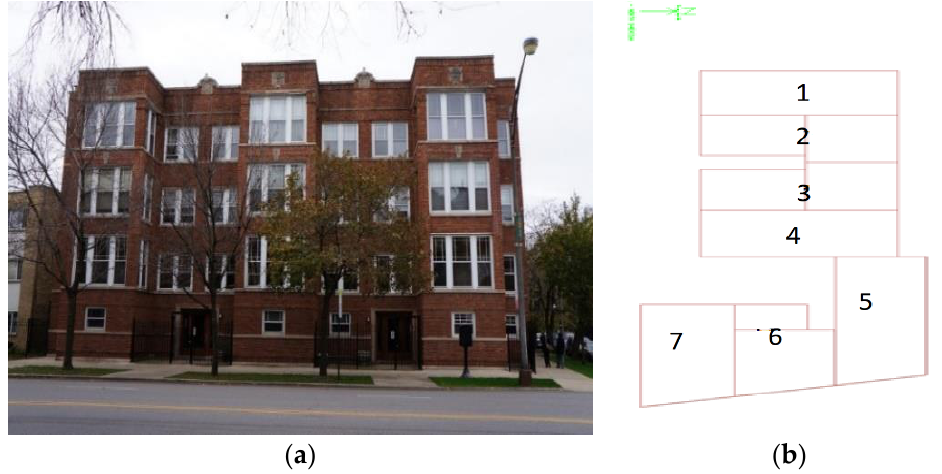
Figure 1. ( a ) Real building East View, ( b ) Building Floors plot including thermal zones positions.